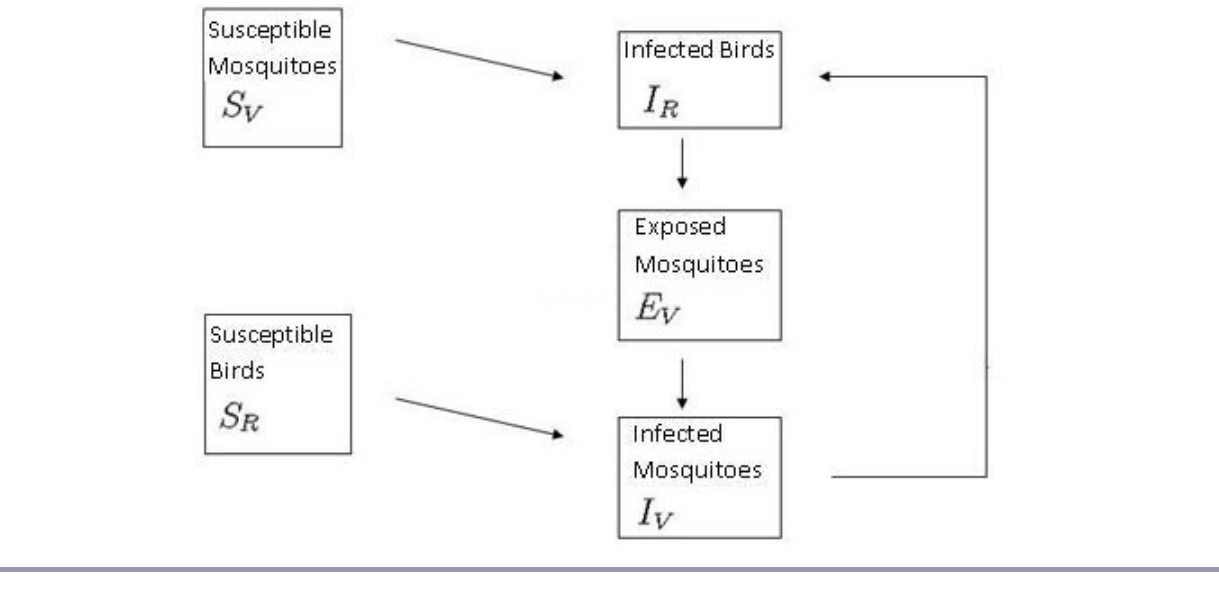
Fig. 4. The interactions between vectors (V) and reservoirs (R) of the three states of birds and mosquitoes: susceptible (S), exposed (E), and infected, denoted by the variables to be used in the formal mathematical